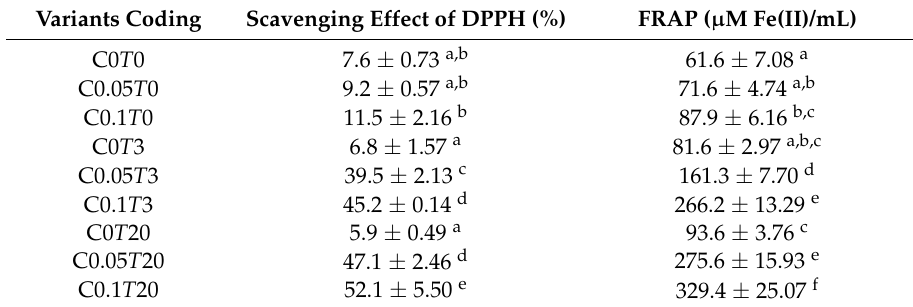
Table 1. Effects of cellulase (C) addition (%) and time of reaction ( T , h) on antioxidant properties